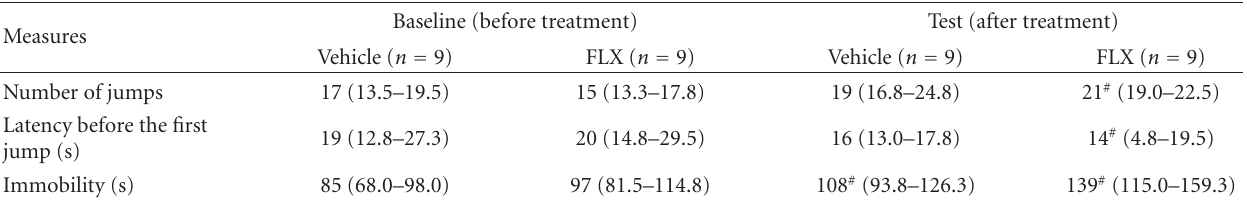
Table 6: E ff ects of acute fluoxetine (FLX) treatment (10mg/kg, IP, n = 9, median with limits of interquartile range values). Wilcoxon-test: # P < 0 . 05 (test versus baseline). Data are expressed as median with limits of interquartile range